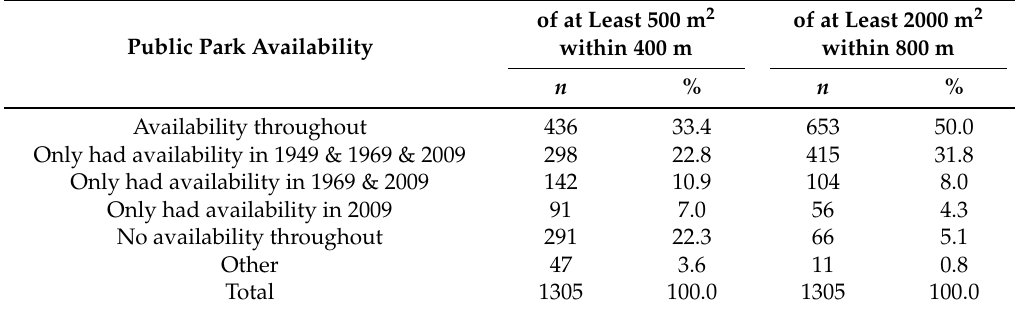
Table 4. Public park availability amongst individuals in the pseudo cohort between 1914 and